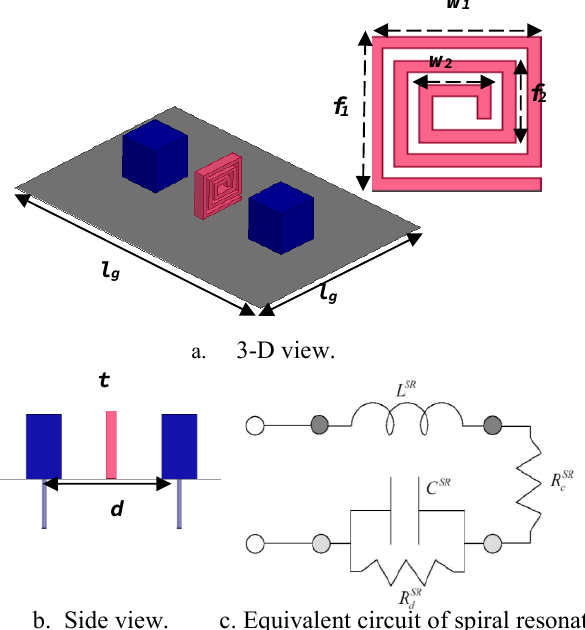
Figure 10: The two element of SDRA antennas array with copper parasitic element and its equivalent circuit.